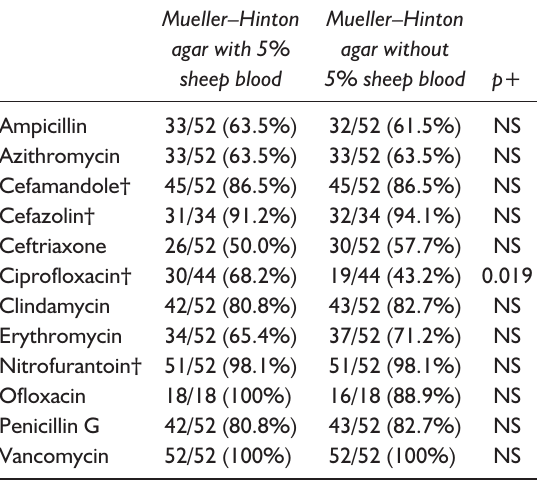
Table 3 Comparison of the frequency of disc diffusion susceptible GBS isolates in Mueller–Hinton agar with